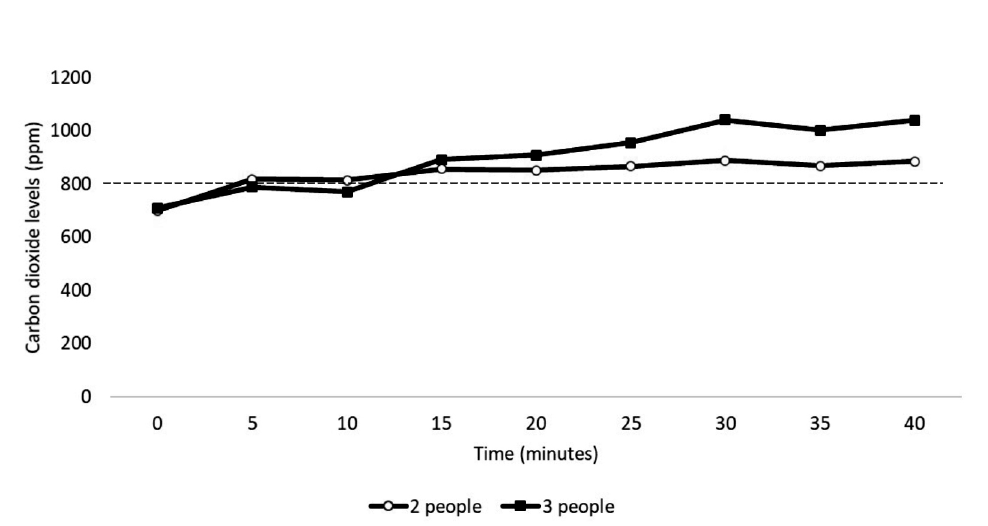
Figure 3: Hotel . Peak carbon dioxide levels at various locations inside a hotel. Peak levels above 800 PPM (dotted line) were considered an indicator of suboptimal ventilation for the number of occupants present. PPM, parts per million.